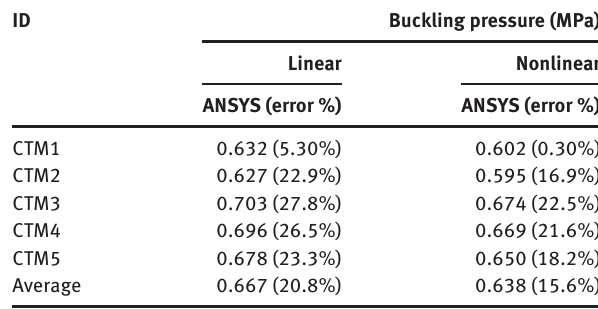
Table 4: Finite element buckling